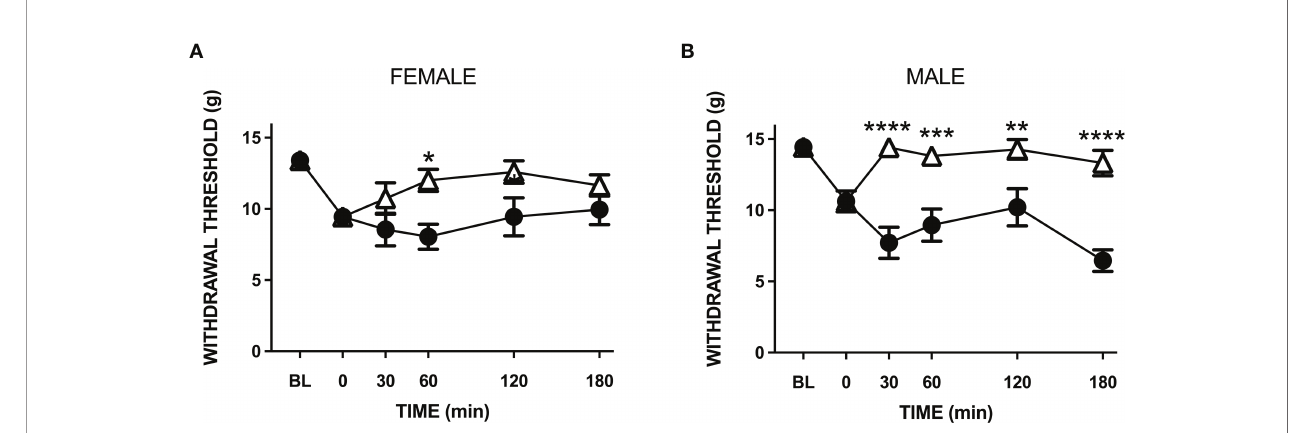
FIGURE 5 | Anti-nociceptive effect of amitriptyline in LPA-injected neuropathic joints. Compared to vehicle control (closed circles) systemic administration of amitriptyline (open triangles) reduced secondary allodynia in both female (A) and male (B) LPA animals. (*P < 0.05; **P < 0.01; ***P < 0.001; ****P < 0.0001 two-way ANOVA with Holm-Sidak post hoc multiple comparisons test; n = 9-10 animals/group). Data are means